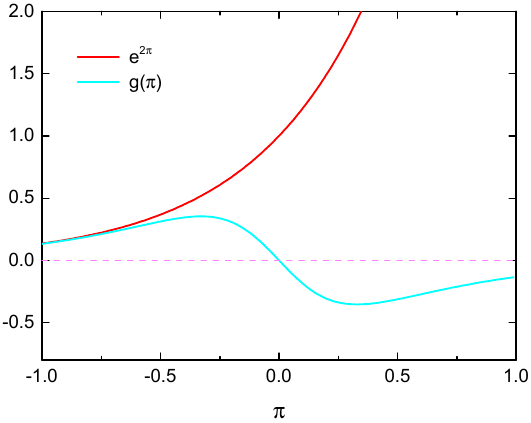
Figure 1. Plots of the coefficient g as a function of the scalar field π . The solid blue curve depicts the form of g ( π ) in the eq. (3.1), and the solid red line represents the traditional model of Galilean Genesis as described by eq.